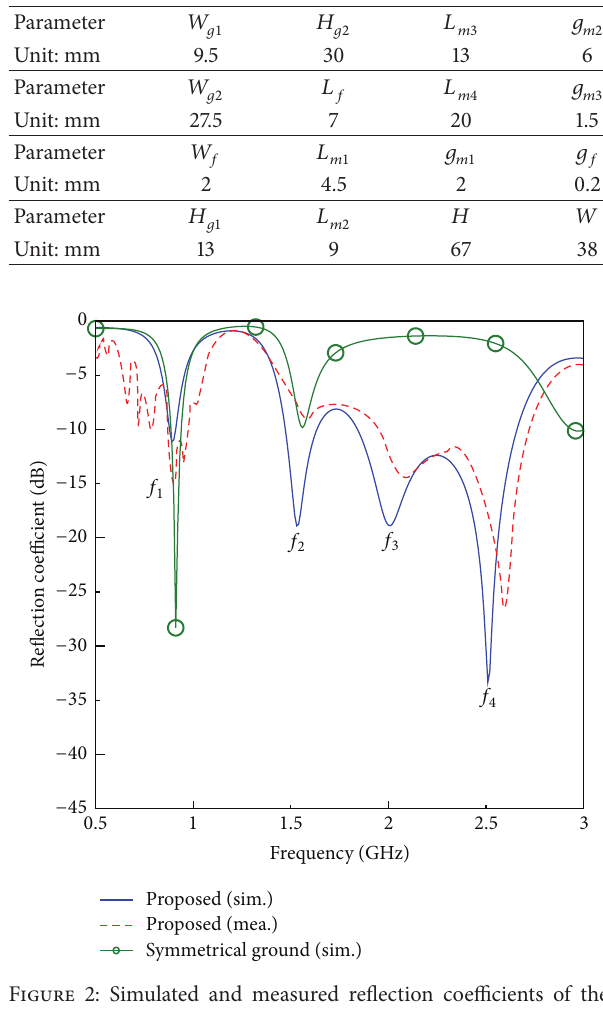
Table 1: Geometric parameters of proposed antenna.